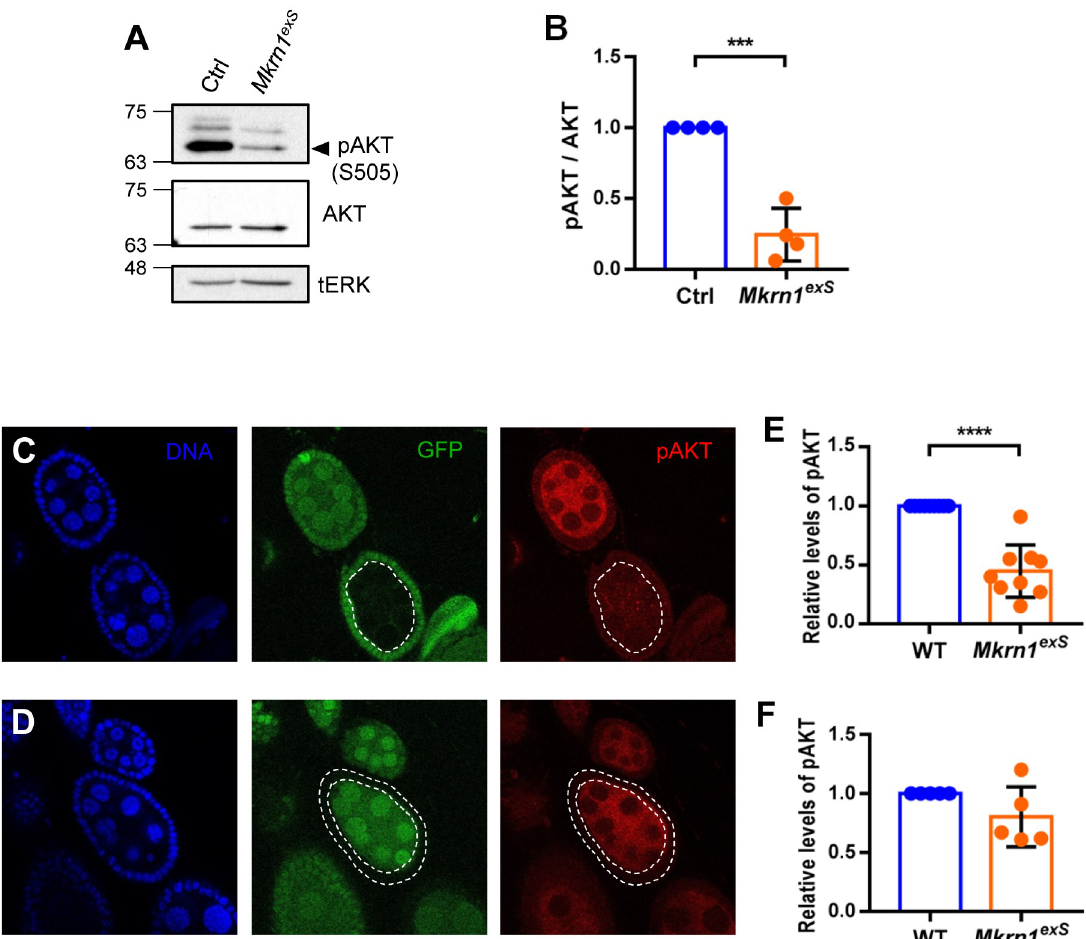
Fig 4. p-AKT levels were reduced in Mkrn1 exS ovaries. (A) Protein extracts were prepared from ovaries of one-day-old control and Mkrn1 exS female flies and analyzed by western blot using anti-p-AKT and anti-AKT antibodies, and tERK as the loading control. (B) Relative p-AKT levels were quantified by measuring band intensities and normalized by total AKT protein levels. Error bars represent SEM from four independent experiments. Asterisks indicate statistically significant differences (Student’s t-test: ��� P < 0.001). (C–F) Confocal images of immunostaining for p-AKT (red) and DNA (blue) of ovaries from Mkrn1 exS flies containing mutant germline and follicle cells. Mkrn1 exS cells are distinguished by the absence of GFP (green). p-AKT level were significantly reduced in Mkrn1 exS germline cells, but not in Mkrn1 exS follicle cells. Fluorescence intensities of p-AKT were quantified and Mkrn1 exS germline cysts were compared with similarly sized neighboring wild-type germline cysts. Mkrn1 exS follicle cells were quantitated and compared to nearby wild-type follicle cells. Error bars represent SEM for 10 germline clones and five follicle clones. Asterisks indicate statistically significant differences (Student’s t-test: � P < 0.05; ���� P <